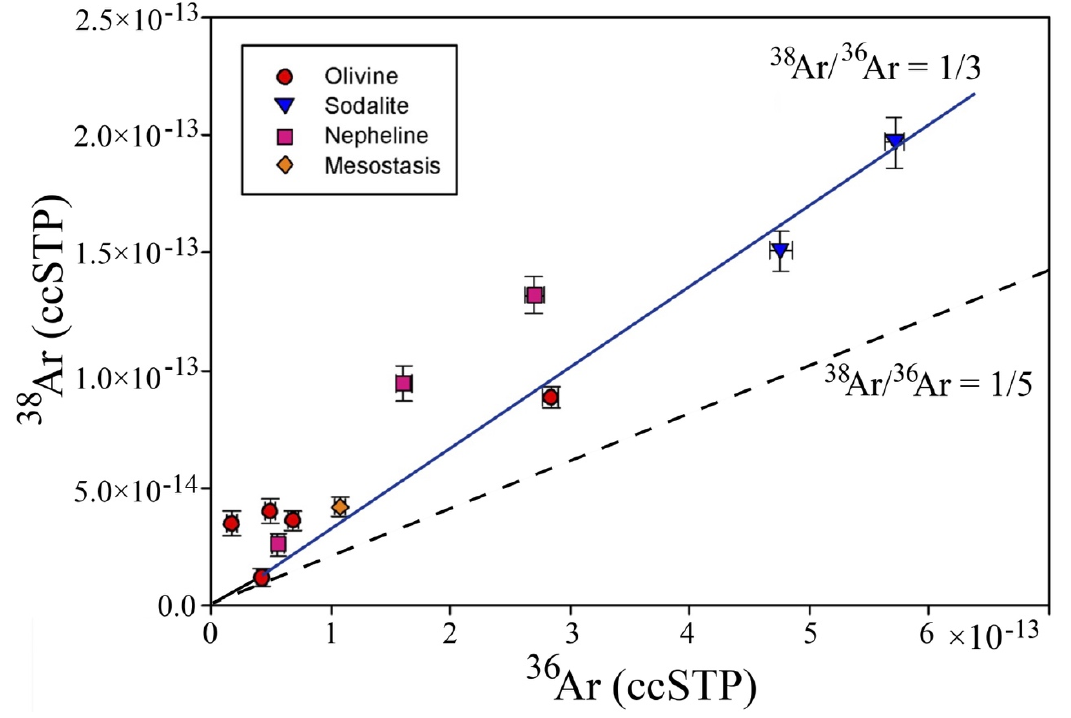
Figure 9. 38 Ar versus 36 Ar plot of olivine (circle), sodalite (triangle), nepheline (rectangle), and mesostasis (diamond). The solid and dashed lines in this figure are 38 Ar/ 36 Ar =1/3 and 38 Ar/ 36 Ar =1/5, respectively.